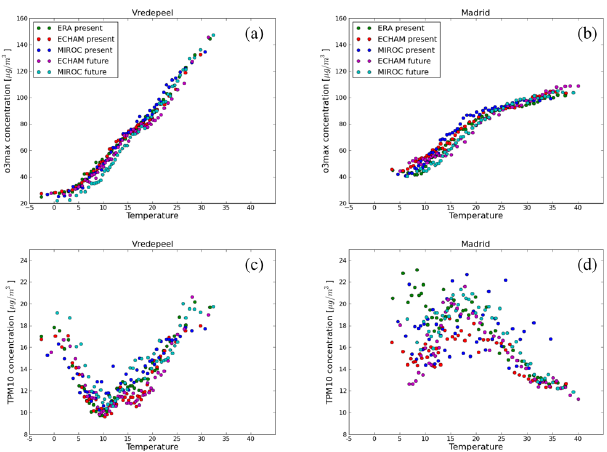
Fig. 10. Average relationship between either (a, b) ozone daily maximum or (c, d) total PM 10 from LOTOS-EUROS and daily maximum temperature ( ◦ C) for the meteorologies downscaled with